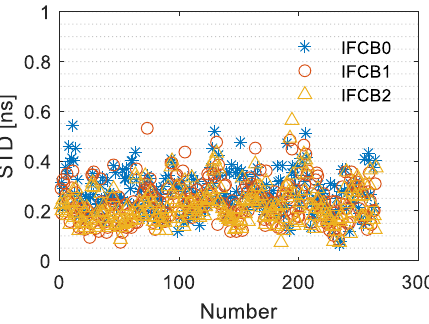
Figure 12. The STD of the 10-day arc solutions without fixed coordinates at three handle schemes. Table 7. The uncertainty (STD) of the GLONASS PPP solutions without fixed coordinates (ns).